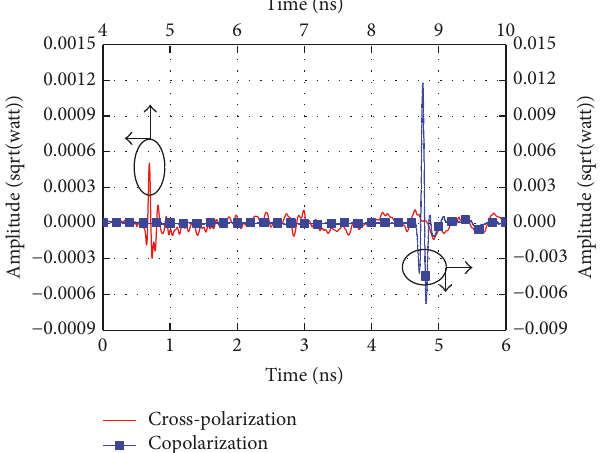
Figure 8: The transmission of short pulse signals between two